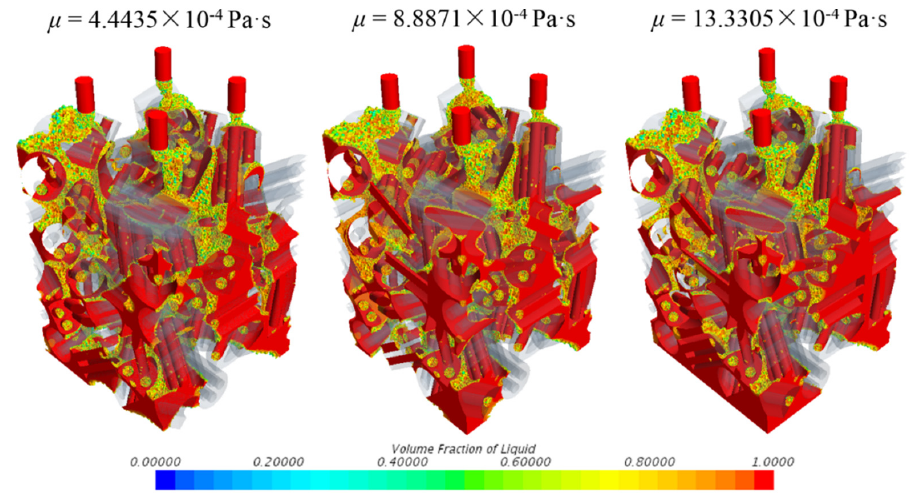
Figure 7. Liquid distributions with three liquid viscosities ( v G = 0.245 m/s, v L = 0.008 m/s).